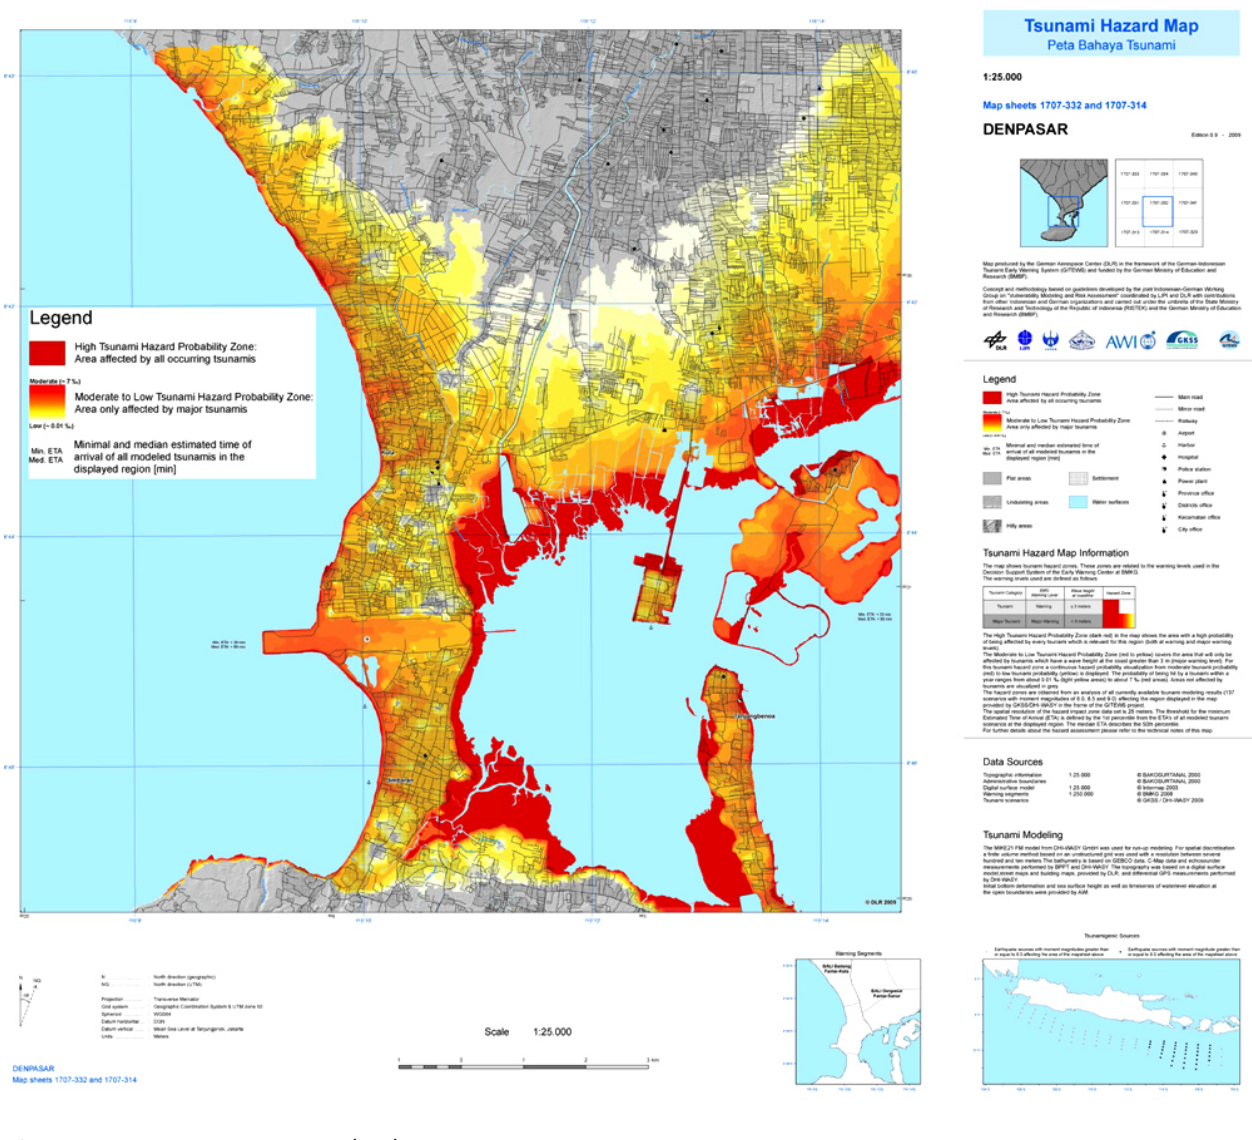
Fig. 10. Tsunami hazard map of Kuta